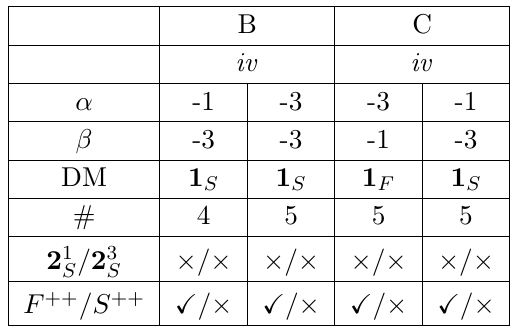
Table 8. The same as in table 2 for Class 1.g of (cid:12)gure